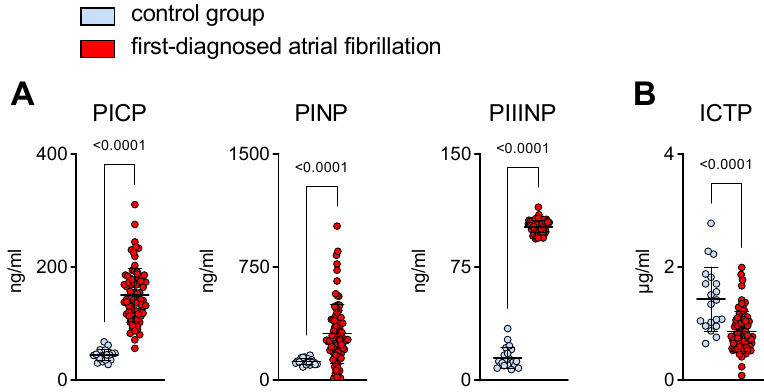
Figure 3. Increased plasma markers of collagen turnover in patients with first-diagnosed AF. Elevated surrogate markers of collagen synthesis (procollagen I C-terminal propeptide, PICP; procollagen I N-terminal propeptide, PINP; procollagen III N-terminal propeptide, PIIINP) ( A ) and reduced collagen degradation fragments (C-telopeptide of type I collagen, ICTP) ( B ) in the plasma of early AF patients ( n = 80) vs. controls ( n = 20). Results are expressed as single values, mean ± SD, and p -values.